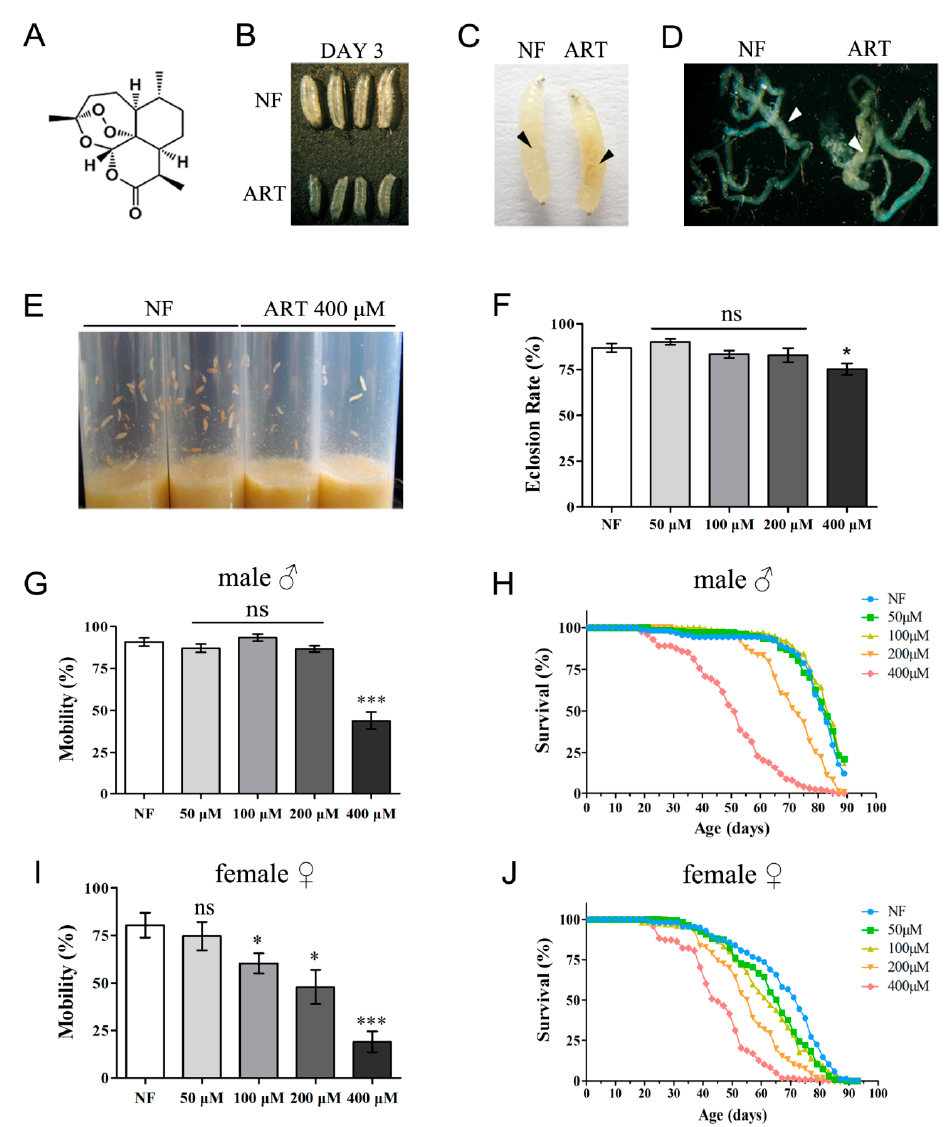
Figure 1. ART negatively impacted Drosophila in a concentration-dependent manner at 25 °C. ( A ) The molecular structure of ART. Note a unique endoperoxide bond situated in the sesquiterpene backbone. ( B ) Effect of ART on the growth and development of Drosophila larvae. After three days of culturing, typical growth of the larvae fed on normal food (NF) or 400 μ M ART food was shown. ( C , D ) When the larvae reach a similar size (which takes longer for larvae grown on ART food), the larvae fed with ART food have a dark yellow midgut (black arrows in C and white arrowheads in D indicate the changed areas). ( E ) An obvious developmental delay on ART food. Food was provided with the standard cornmeal as the NF and mixed with 400 μ M ART as the ART food. ( F ) The eclosion rates of the fly on food mixed with a set of concentrations of ART were measured, and a significant decrease in eclosion rate could be observed on high levels of drug diet. ( G ) The mobility defect could only be seen at high concentrations of ART food (400 μ M) for male flies. ( I ) Dosage- dependent mobility defect of female flies was observed. ( H , J ) ART shortened the lifespan of male flies and female flies. The x -axis refers to the age of adult flies. The longevity changes on the ART diet are correlated with the phenotype of movement disorder for both female and male flies. Flies